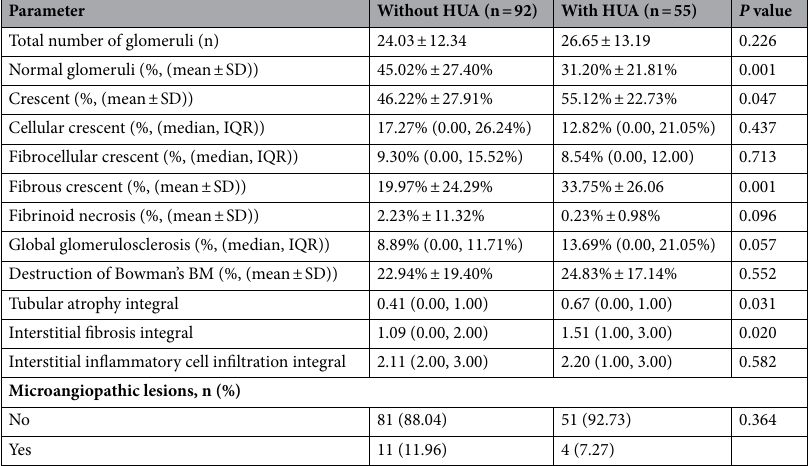
Table 2. Pathologic characteristics of AAV-related renal involvement patients with or without hyperuricemia at the time of biopsy. Values for continuous variables were given as the mean ± standard deviation (for normally distributed data) or median (interquartile range [IQR]; for nonnormally distributed data). The semi- quantitative scoring system was used to analyze tubulointerstitial lesions. Values for categorical variables were given as number or number (percentage). P value: comparison between two groups. P < 0.05 was considered as significant. HUA, hyperuricemia; BM, basement membrane.